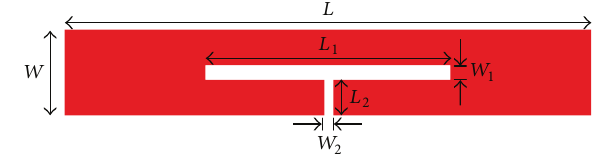
Figure 4: T-shape DMS structure: 𝐿 1 = 14 mm, 𝑊 1 = 0.8 mm, 𝐿 2 = = 0.6 mm, 𝐿 = 30 mm, and 𝑊 = 4.8 mm. 2 mm, 𝑊 2